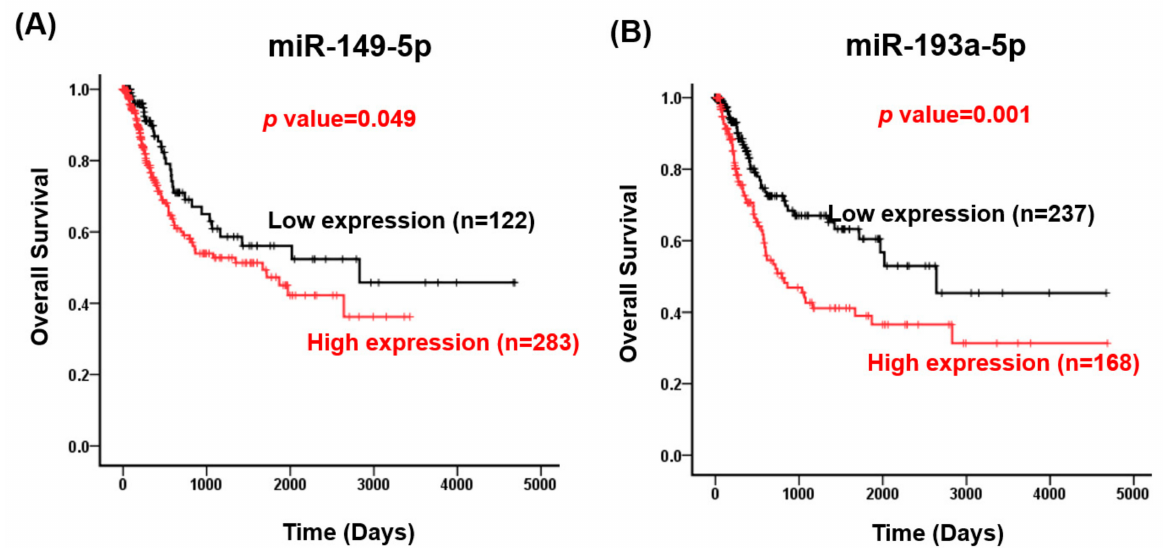
Figure 3. Expression levels of miR-149-5p and miR-193a-5p were highly associated with the survival curve of patients with bladder cancer. The receiver operating characteristic curve was used to define cutoff values for miR-149-5p and miR-193-5p expression levels. According to the defined cutoff values (69 for miR-149-5p and 199 for miR-193-5p ), the patients were divided into groups according to whether they had high or low expression levels of miR-149-5p or miR-193-5p . The correlation between miR-149-5p expression ( A ) and miR-193a-5p expression ( B ) was analyzed according to the overall survival curve.